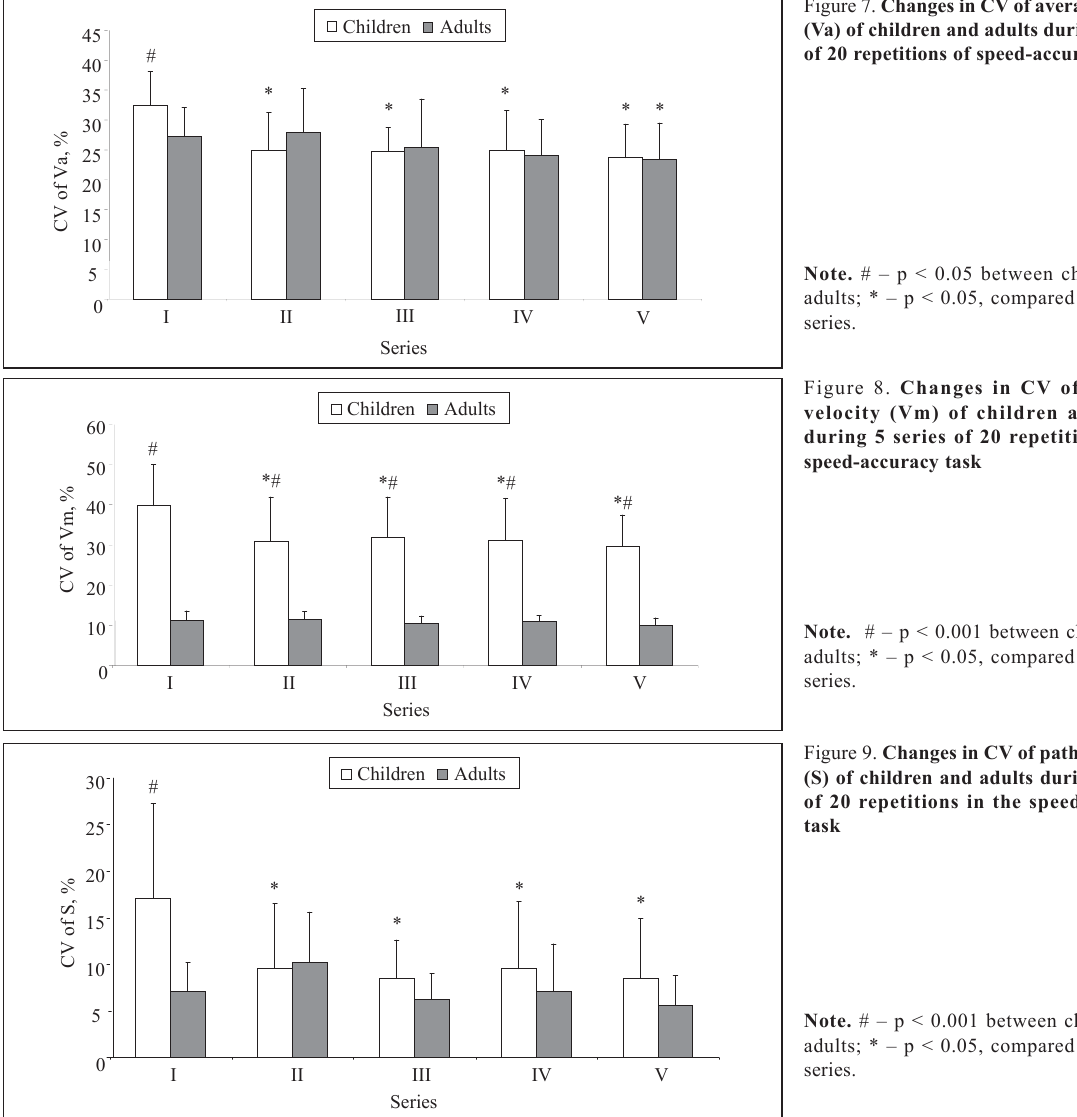
Figure 7. Changes in CV of average velocity (Va) of children and adults during 5 series of 20 repetitions of speed-accuracy task